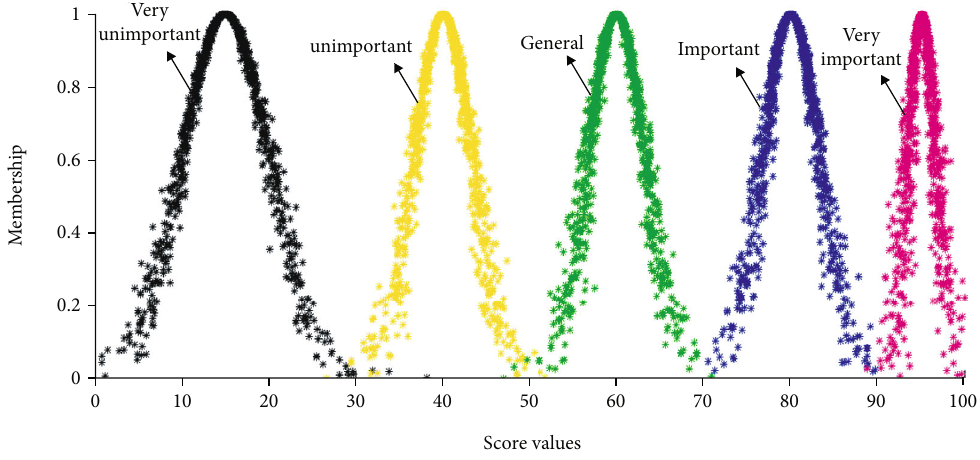
Figure 4: The signi fi cance evaluation standard cloud. Table 3: Important scale